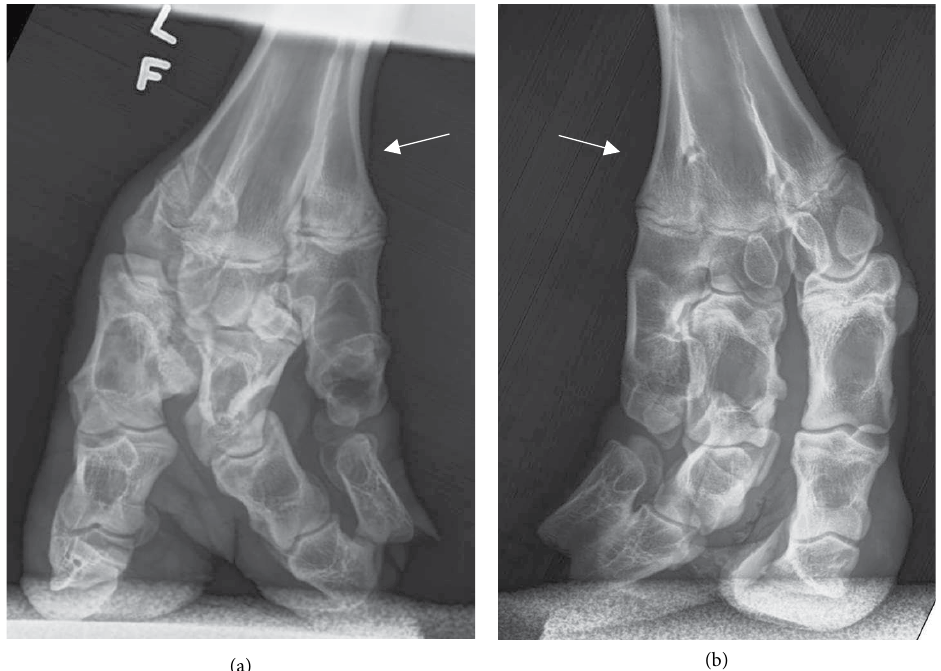
Figure 4: Palmodorsal radiographs of the front feet of Dexter heifer Case 2 at 11 mo of age. (a) Left front foot. (b) Right front foot. Both feet presented segmented bone development indicating an extra digit next to each medial digit. Each foot presented an extra fused section of the metacarpus (shown by the arrows). The extra digits extended the length of the foot with apparent fusion with the third phalanx of the normal